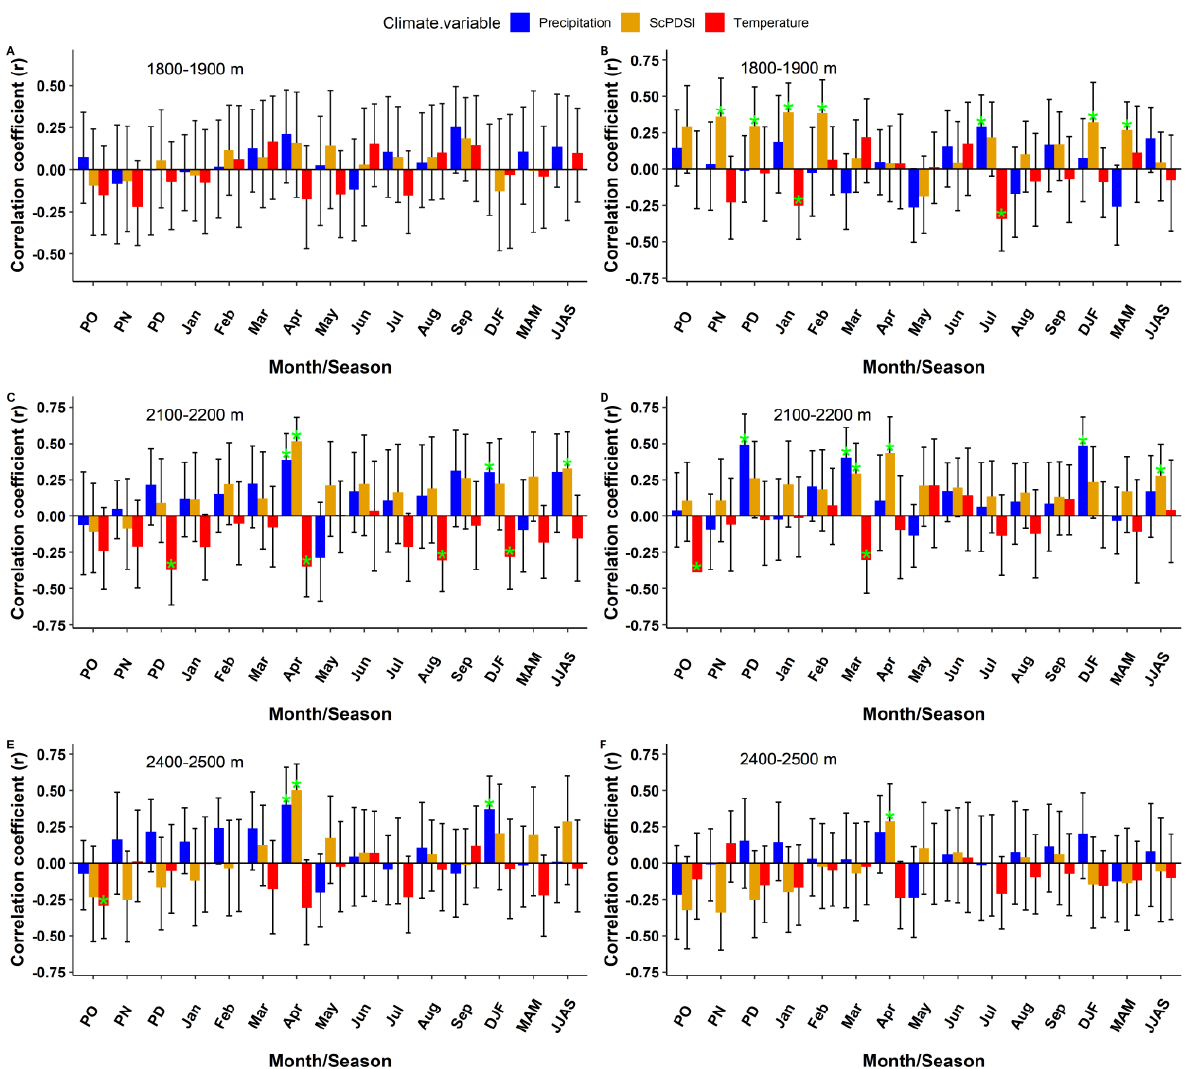
Figure 5. Correlation plot between tree-ring chronologies of P. wallichiana along the elevation gradient and climate variables (temperature, precipitation, and ScPDSI). The X -axis represents a lag-year month, current year month, and current year season. The climatic window includes one water year (previous October (PO) to current year September (Sep)). The bar height ( Y -axis) represents the correlation coefficient, and line height indicates the 95% confidence interval of a Pearson correlation coefficient. The green star (*) in or above the bar indicates the significant correlation between right- width chronology and climate variable at 95% level. The left panel figures ( A , C , E ) are from the northeast aspect and the right panel figures ( B , D , F ) are from the northwest aspect in the study area at lower, middle, and higher elevation belts, respectively. Note: DJF means December, January, and February; MAM means March, April, and May; JJAS means June, July, August, and September.